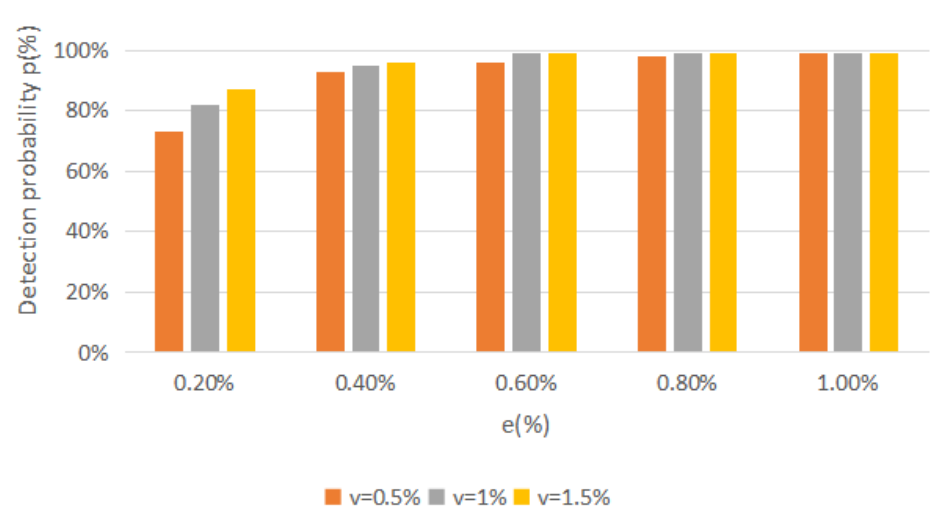
Figure 4. Probability of detecting the dishonest CSP.